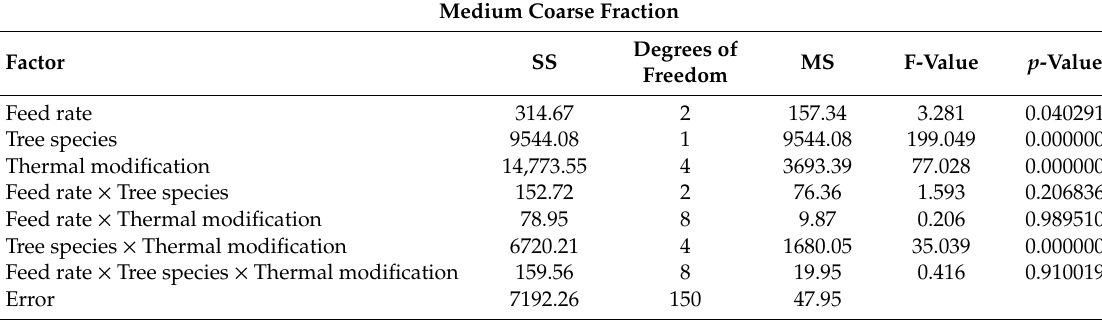
Table 5. Multiple factor analysis of variance in the case of medium coarse